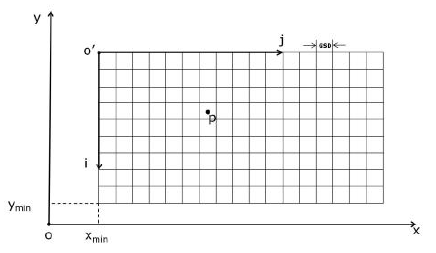
Figure 2. The projection coordinate system and pixel coordinate